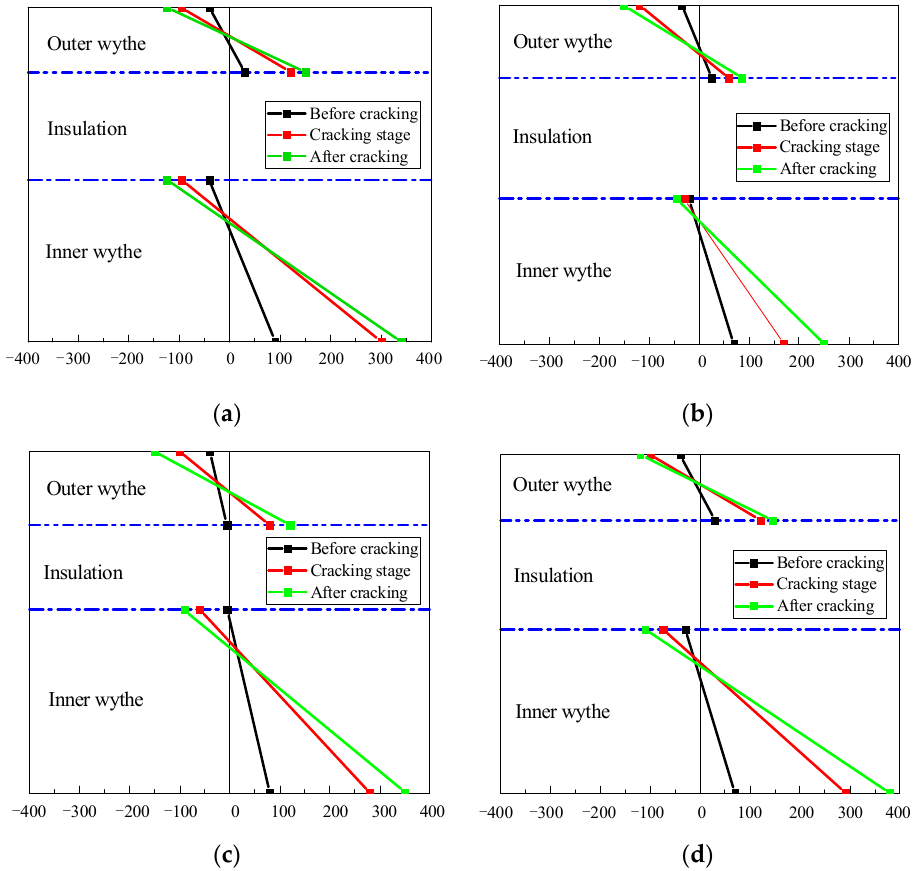
Figure 9. Strain distribution of concrete at midspan section: ( a ) SP-1; ( b ) SP-2; ( c ) SP-3; ( d )